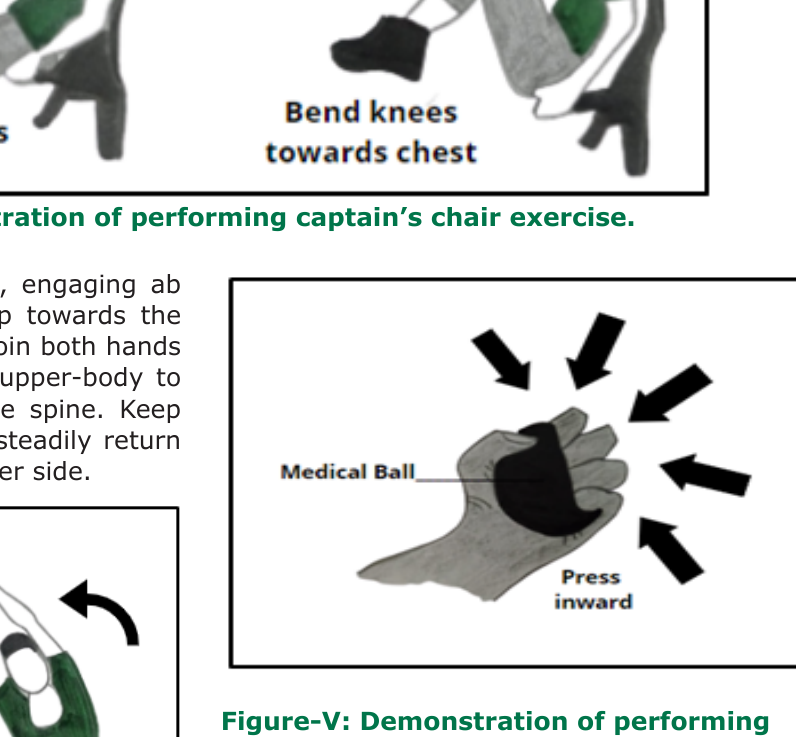
Figure-V: Demonstration of performing palm press exercise.